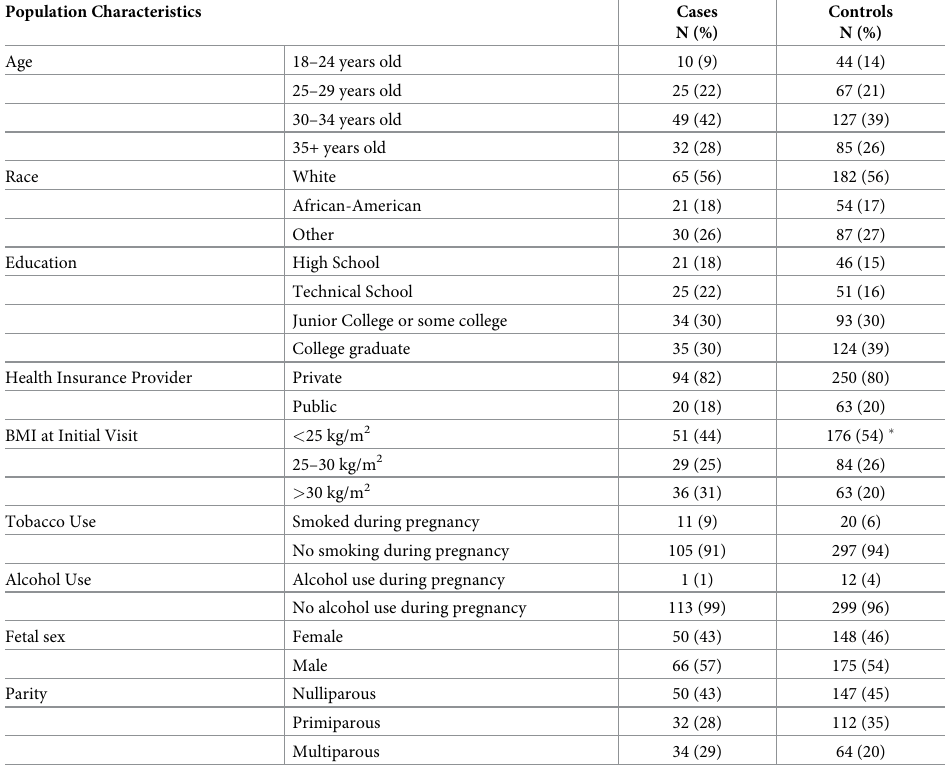
Table 1. Population demographic characteristics by cases (N = 116) and controls (N =